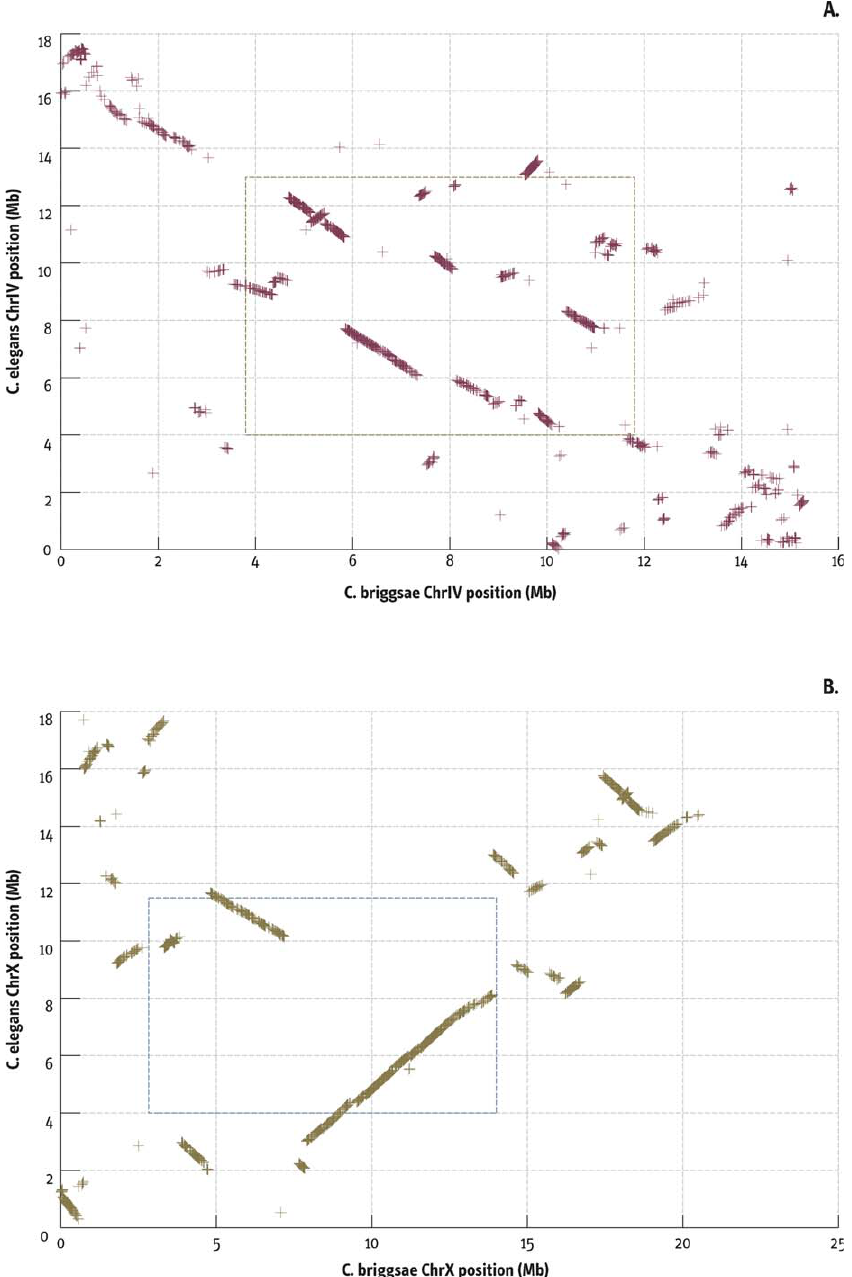
Figure 5. Chromosomal Positions of Orthologs The chromosomal positions of the orthologs in the two species reveals colinearity and breakpoints. The positions of ortholog pairs along the chromosomes of the two species are plotted against one another for chromosomes IV (A) and X (B). The position of each pair is designated with a ‘‘ þ ’’ . Extensive colinearity of pairs produces an apparent line. The box in the center of each panel (dotted line) delimits the region of low recombination based on inspection of the Marey plots (Table 6). See Figure S4 for other chromosomes and for similar data for C. elegans